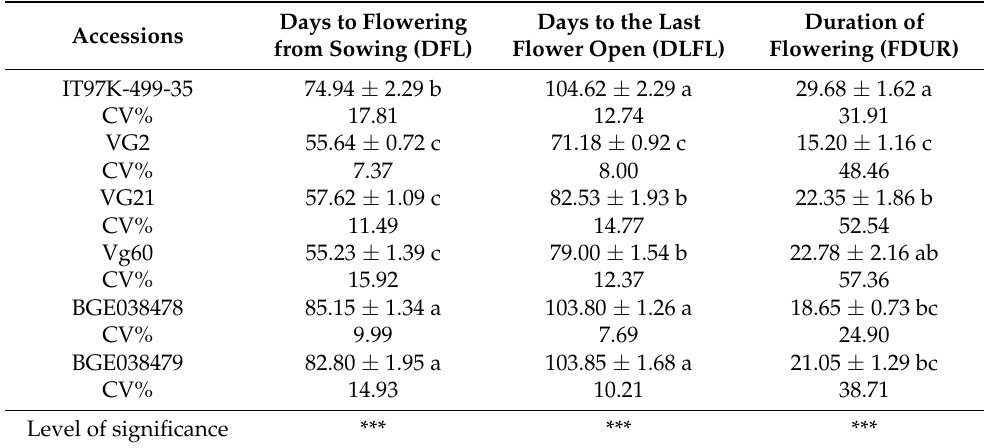
Table 2. Phenological traits and coefficients of variation (CV%) for each cowpea accession and trait studied. Means ± SE in columns with different letters are statistically significantly different at the 0.05 level, by Tukey’s HSD means comparison method. Days to Flowering Days to the Last Duration of Accessions from Sowing (DFL) Flower Open (DLFL) Flowering (FDUR)